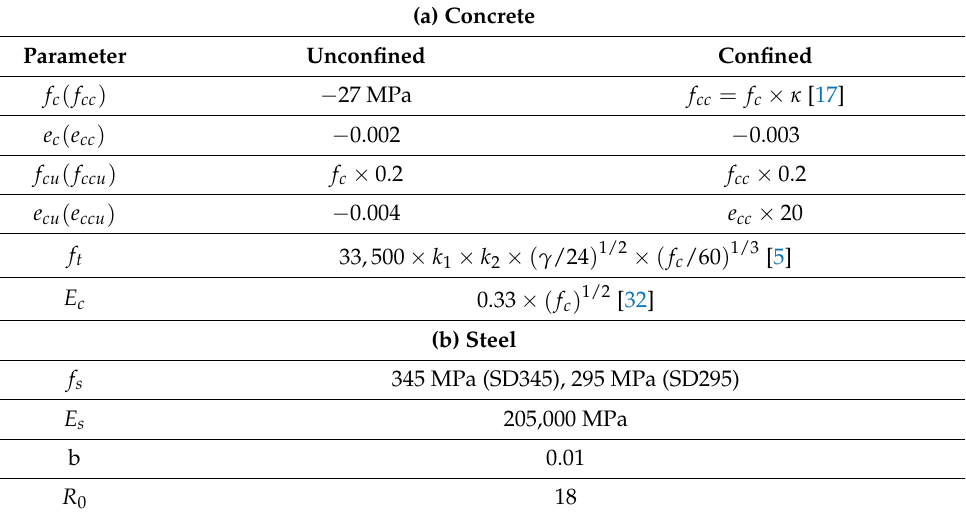
Figure 5. Constitutive material models in compression and in tension for ( a ) concrete; ( b ) steel. Table 7. Modeling material parameters for structural